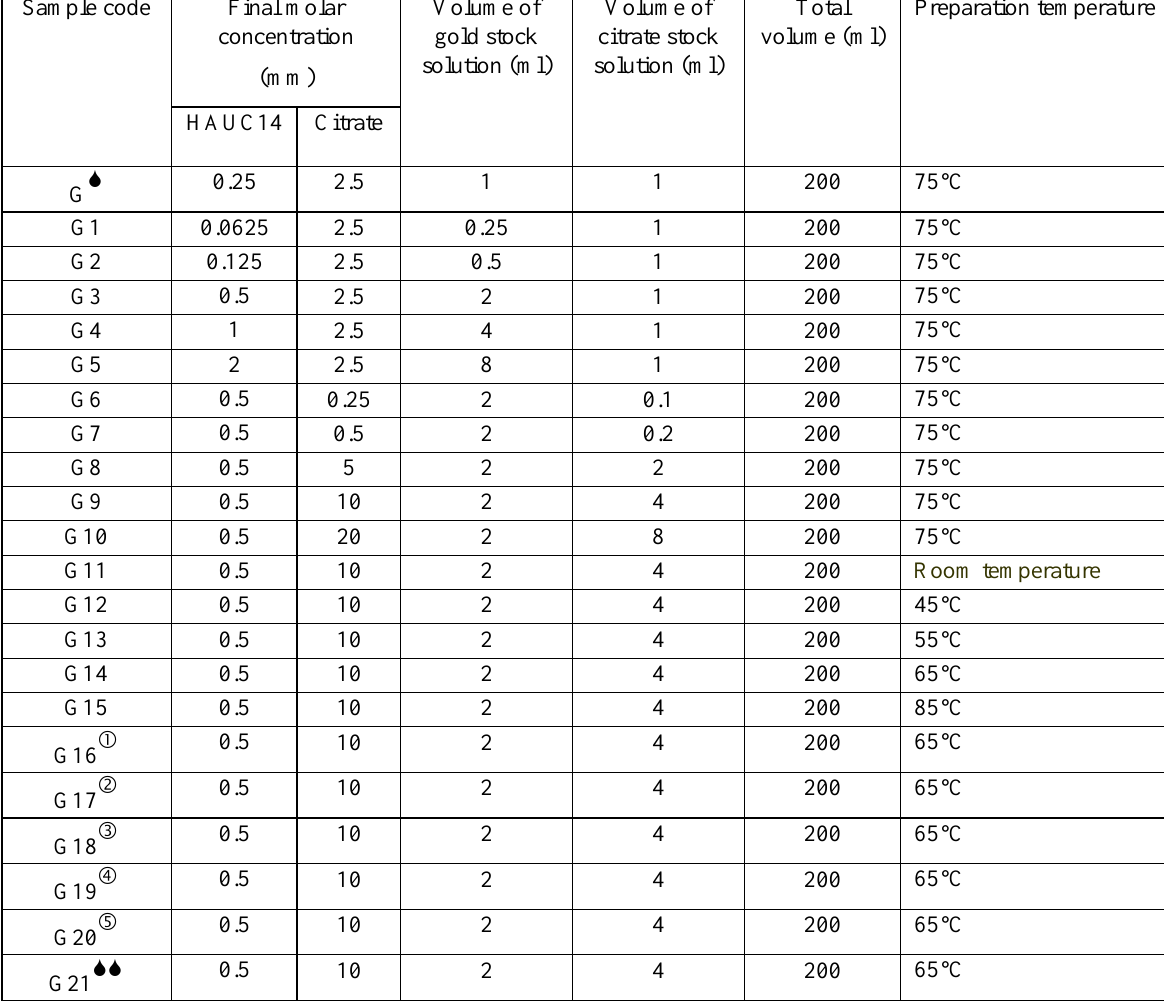
Table 1. Composition of the gold nanoparticles suspensions using different preparation temperature, stirring rate and